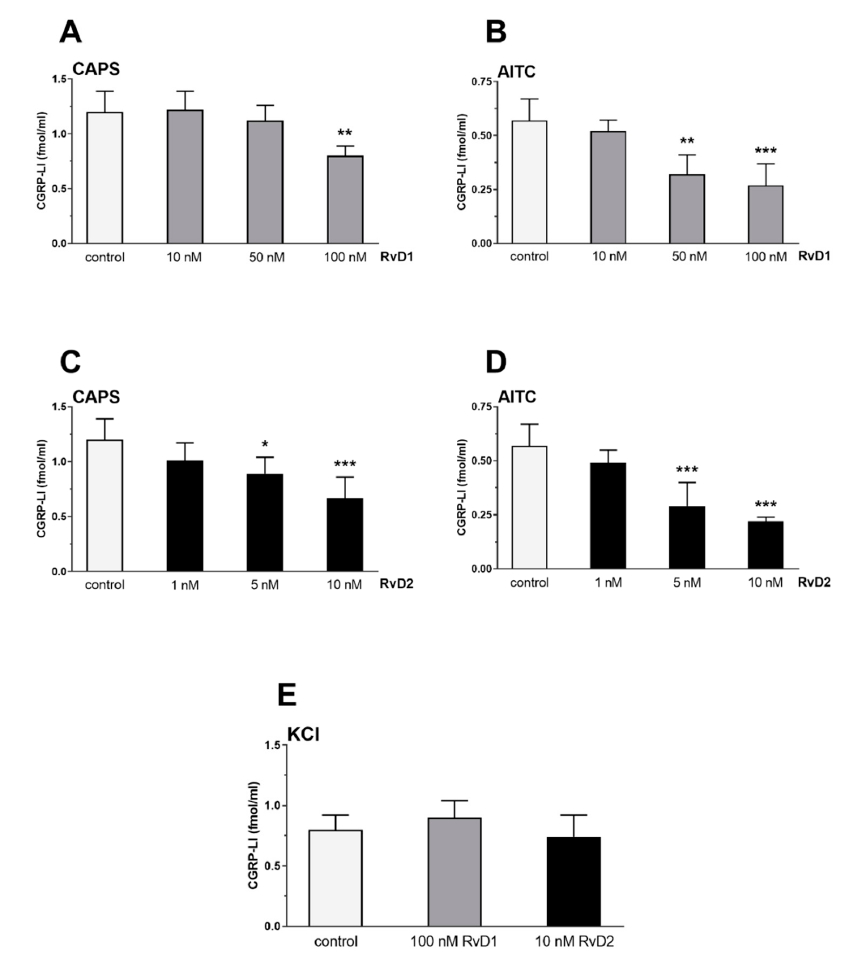
Figure 5. E ff ect of RvD1 and RvD2 on TRPV1 and TRPA1 receptor activation on peripheral